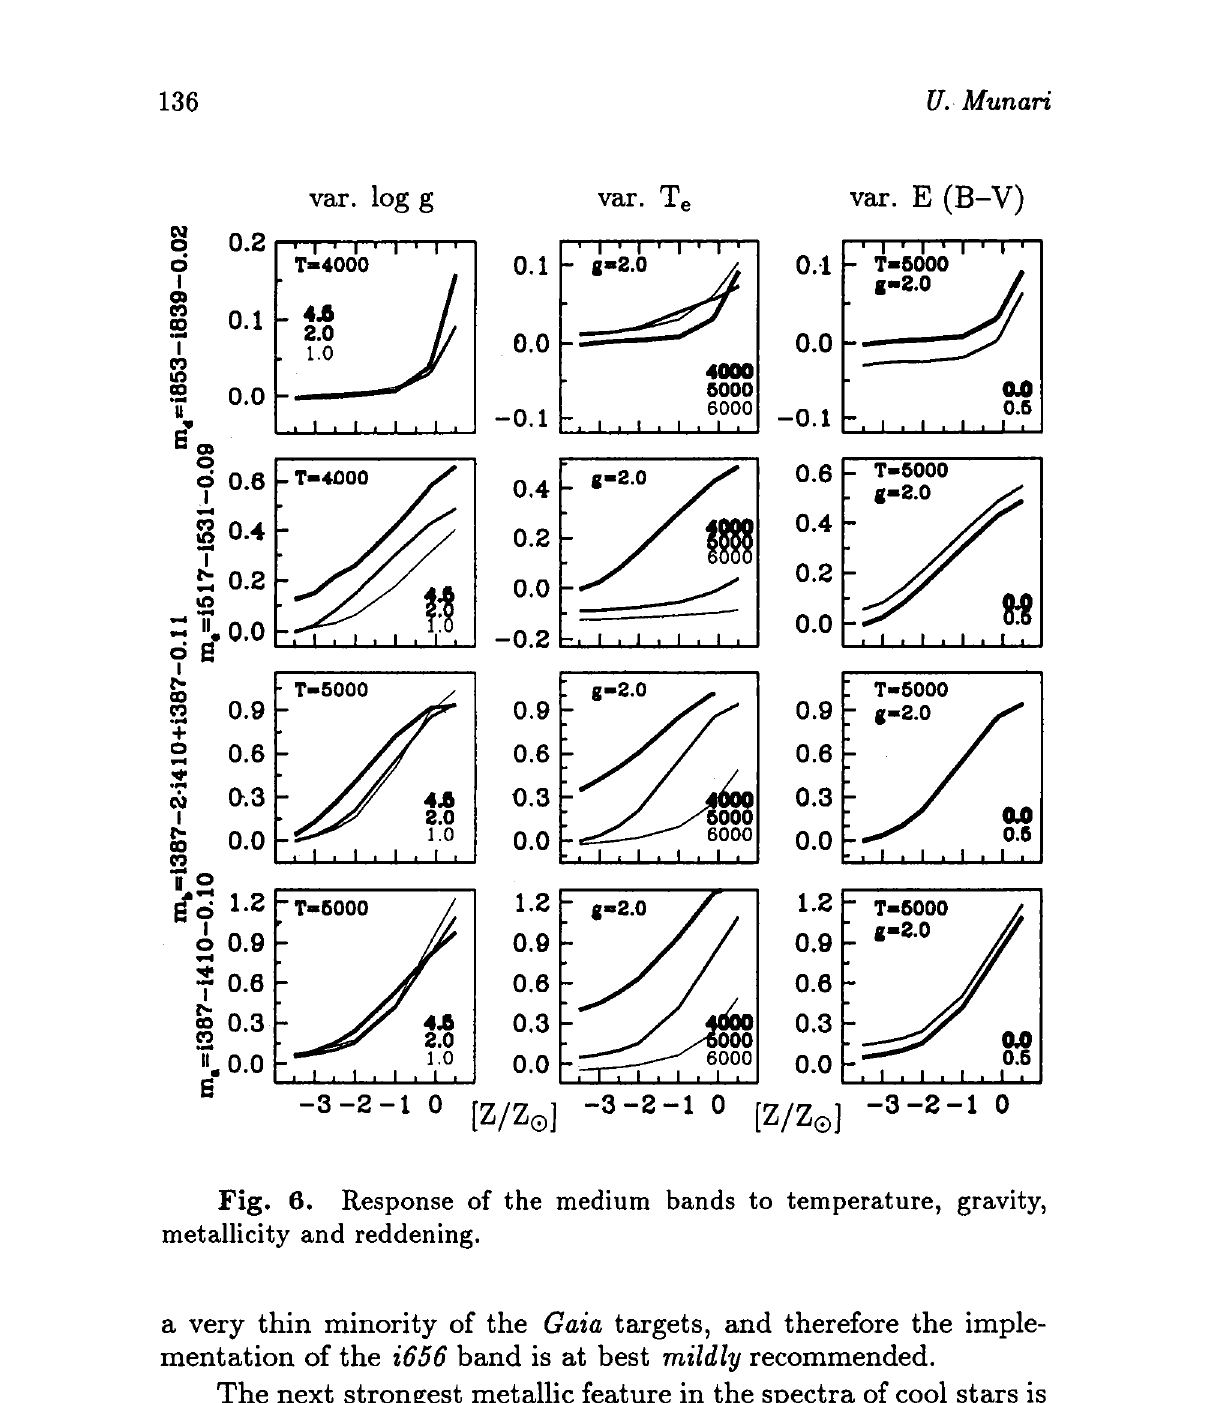
Fig. 6. Response of the medium bands to temperature, gravity, metallicity and